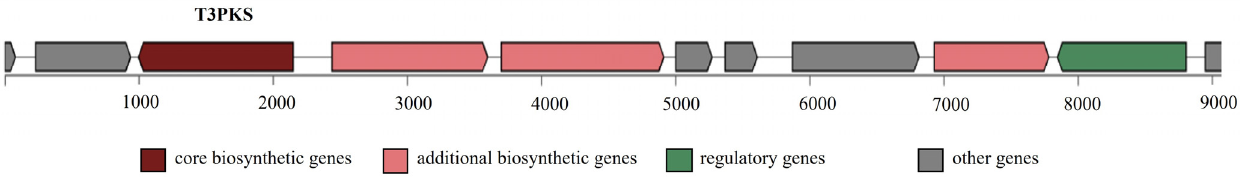
Figure 3. Secondary metabolite-producing region T3PKS in the genome of L. lactis LL16 detected with the antiSMASH 5.0 web tool. The arrows indicate the direction of transcription for each gene and the colours indicate gene function.